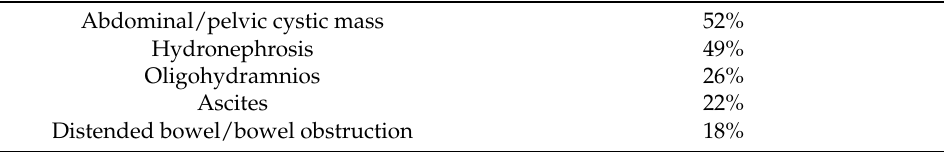
Table 1. Rates of common anomalies identified by prenatal US in patients with cloaca † . Abdominal/pelvic cystic mass 52% Hydronephrosis 49% Oligohydramnios 26% Ascites 22% Distended bowel/bowel obstruction